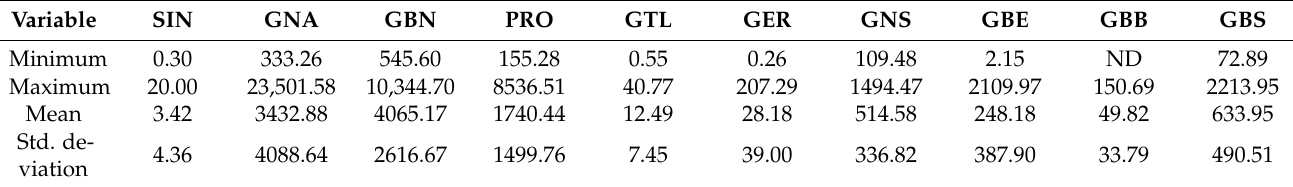
Table 2. Profile of individual glucosinolates in 60 kimchi cabbage germplasm samples ( µ mol · kg − 1